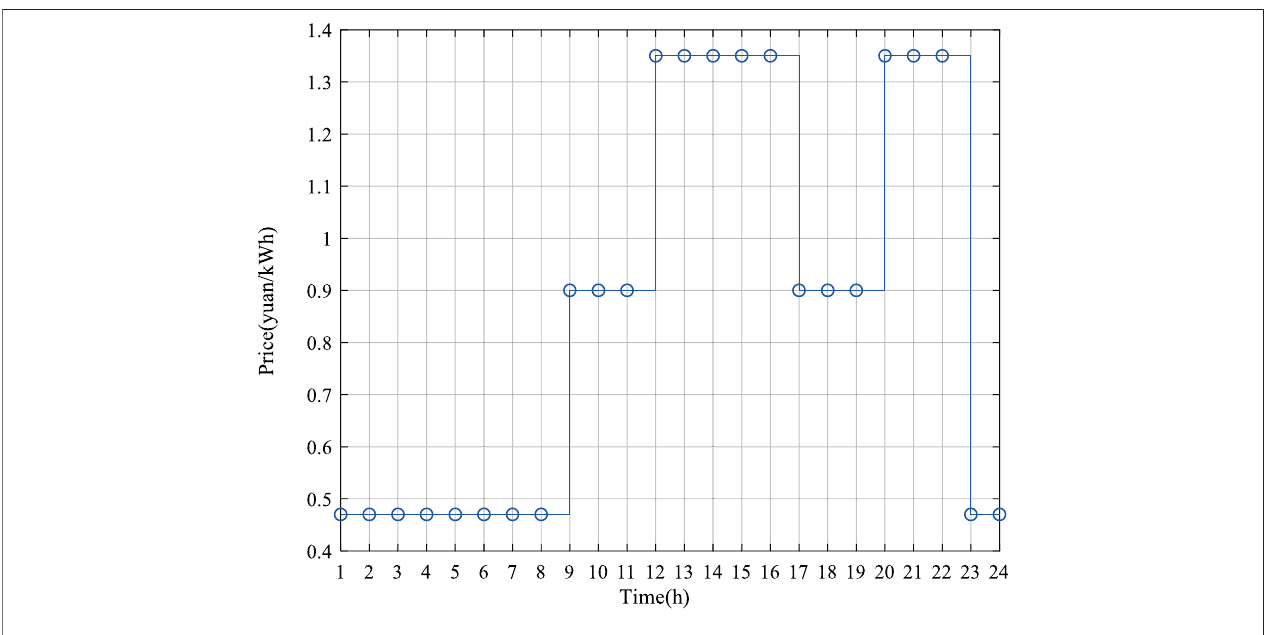
FIGURE 4 | Power purchase price of